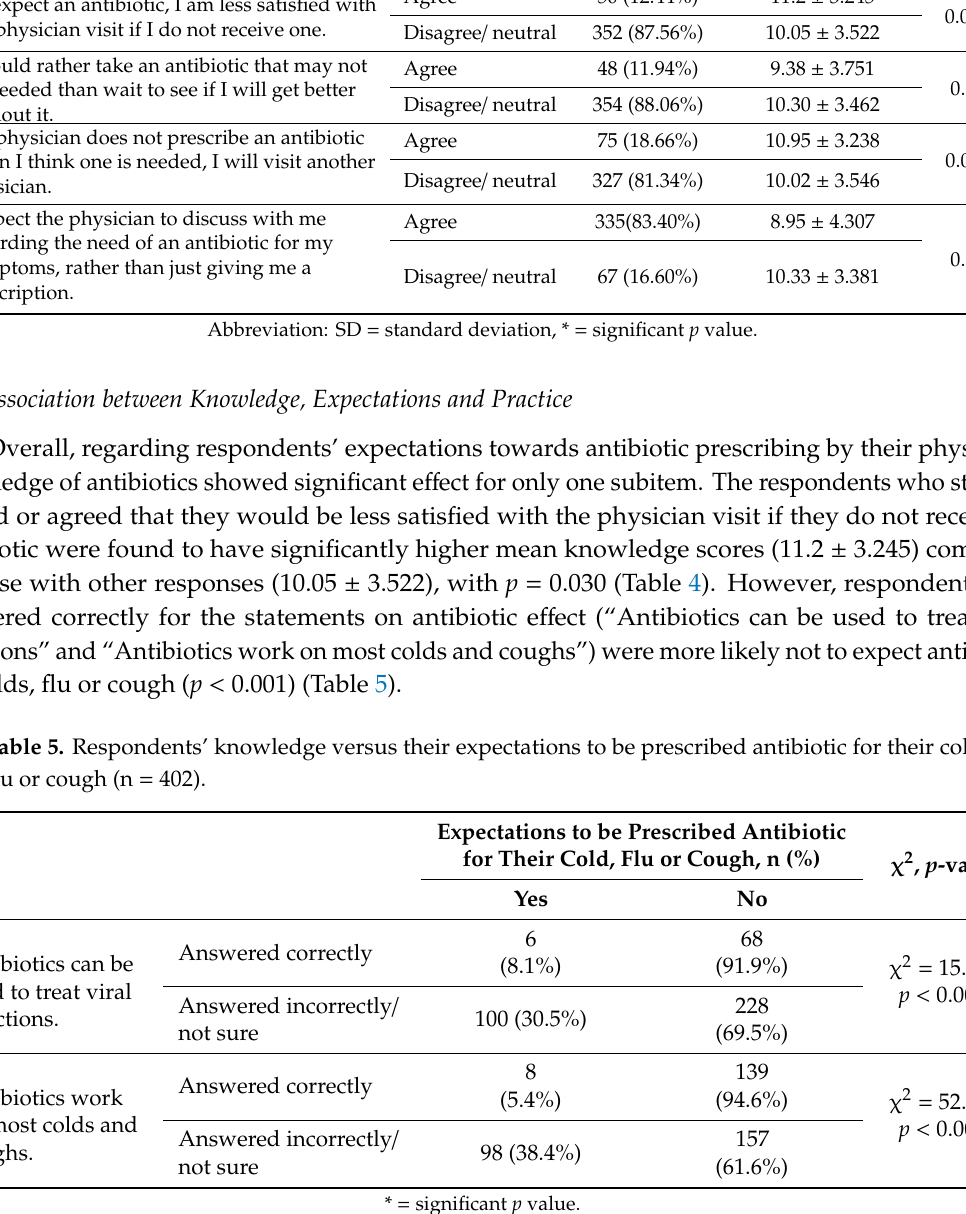
Mean Knowledge p -value n (%) Score ( ± SD)